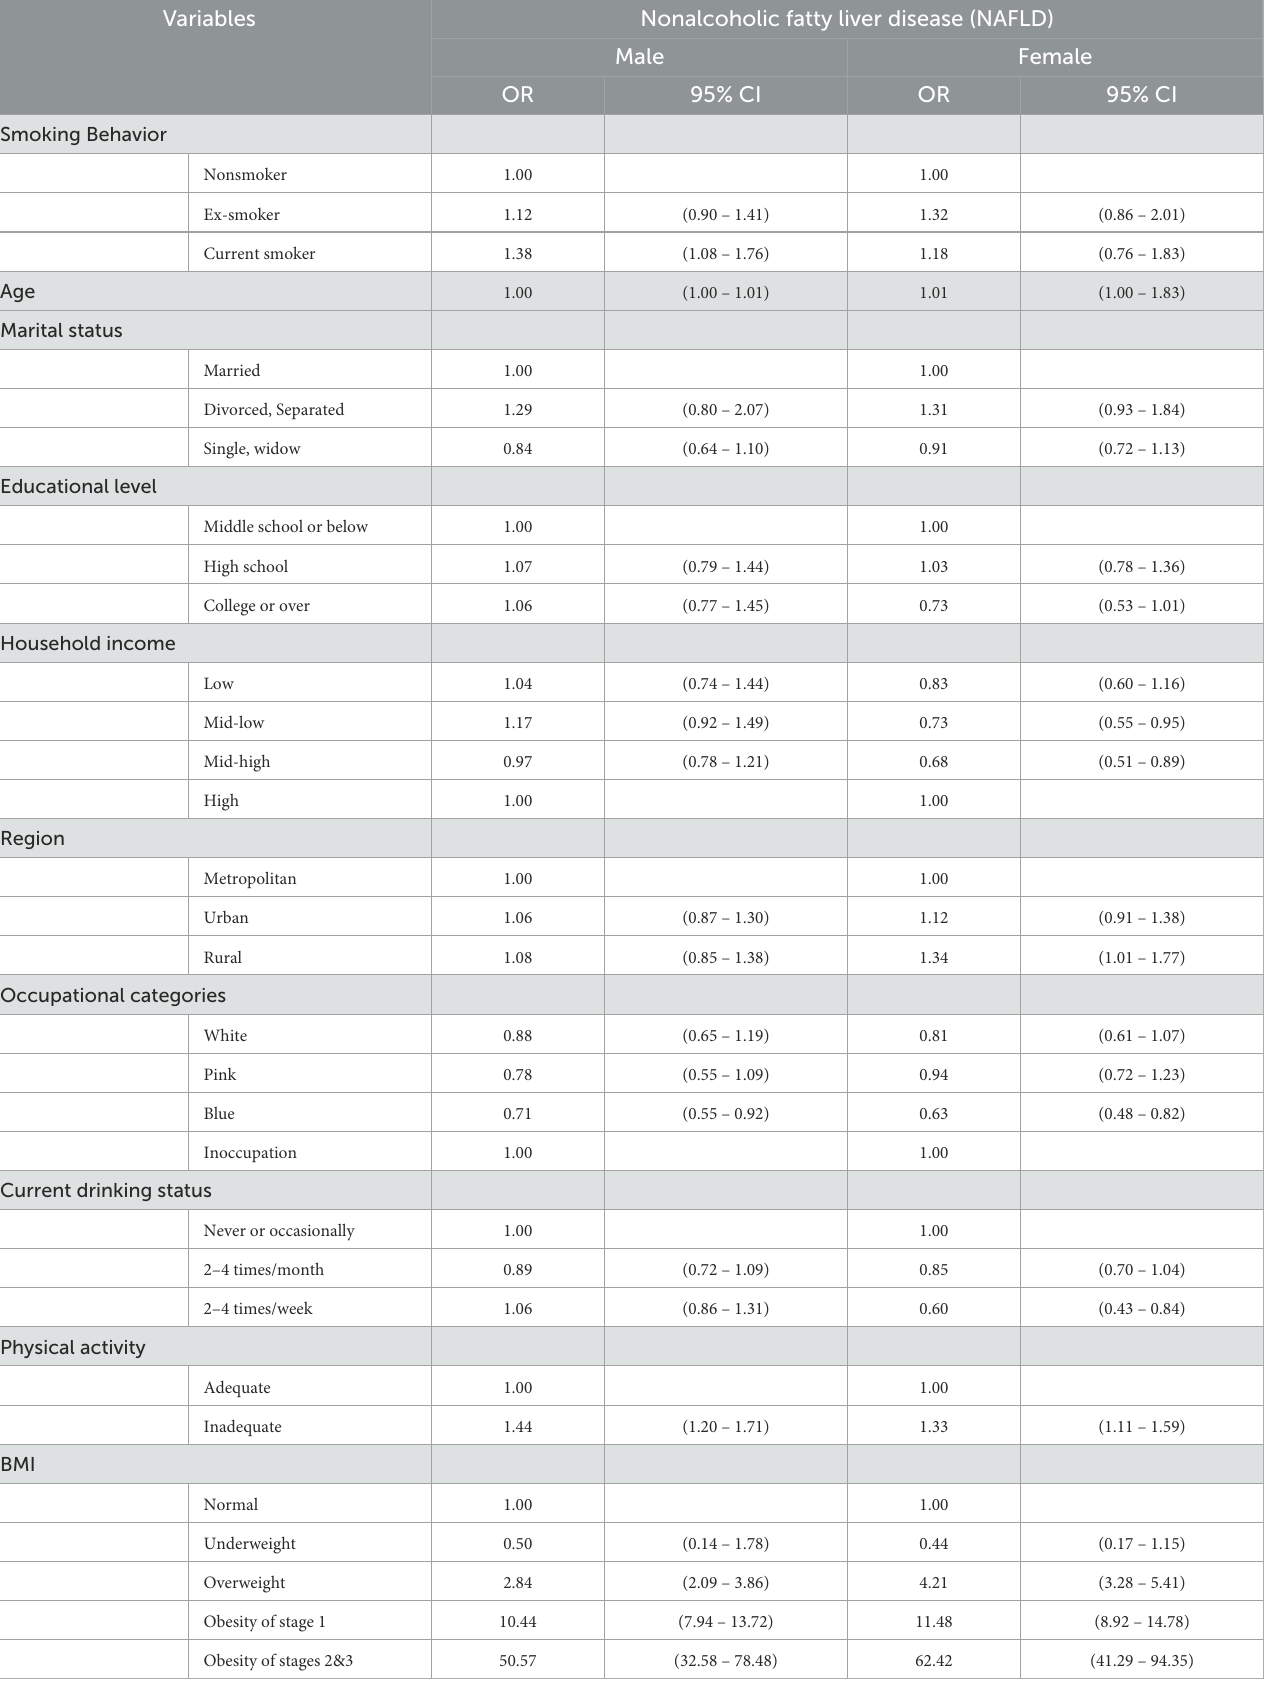
TABLE 2 Results of factors associated between smoking and nonalcoholic fatty liver disease.